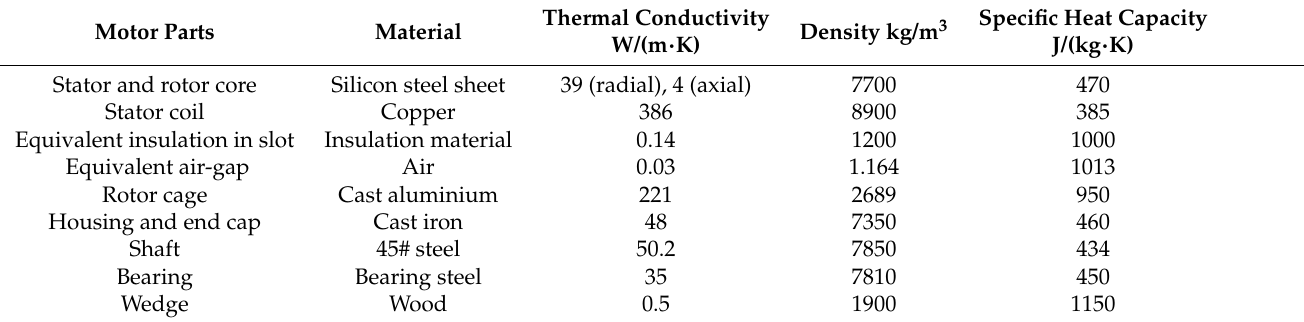
Table 2. Material properties of prototype.